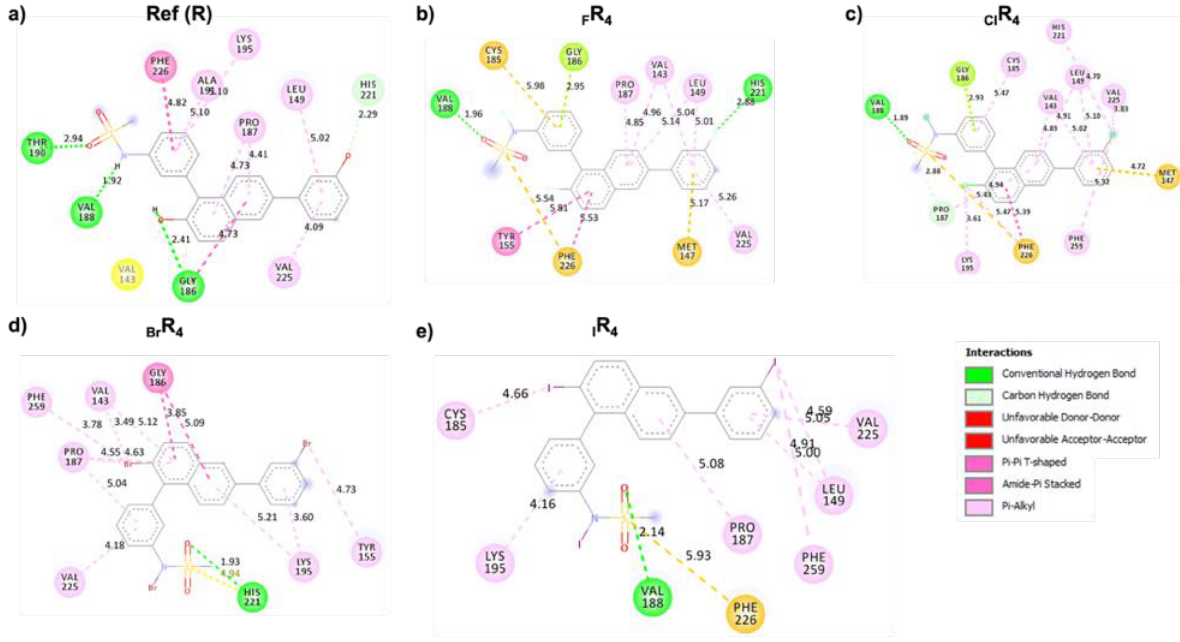
Figure 6. The observed hydrogen-bond and π interactions between 17 β -HSD1 and reference, F R 4 , Cl R 4 , Br R 4 , and I R 4 compounds (( a – e ), respectively). Note: a different color represents residues involved in each kind of interaction.